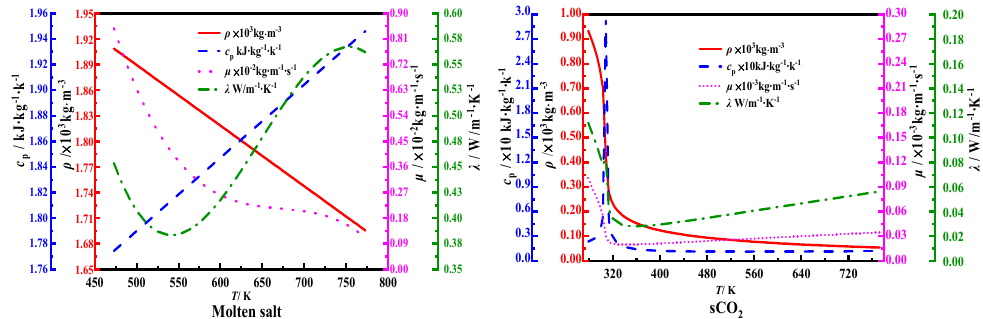
8 MPa, with temperature range of 273–773 K.